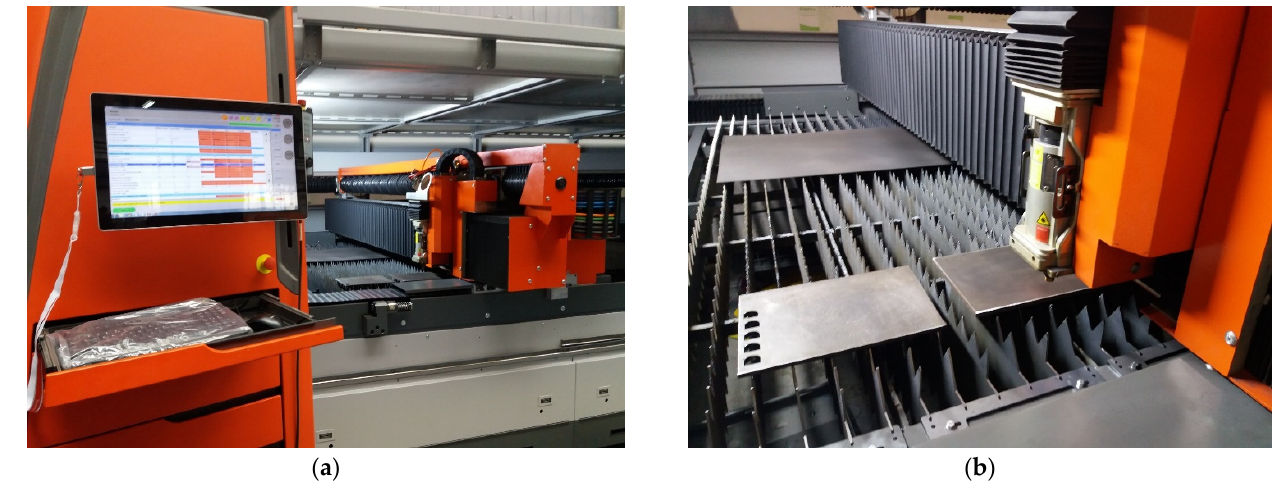
Figure 2. Images with By Autonom 4020 Laser Installation. ( a ) Before processing; ( b ) During processing.